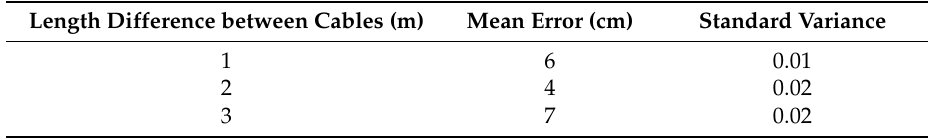
Table 2. Statistical results for different length cables.